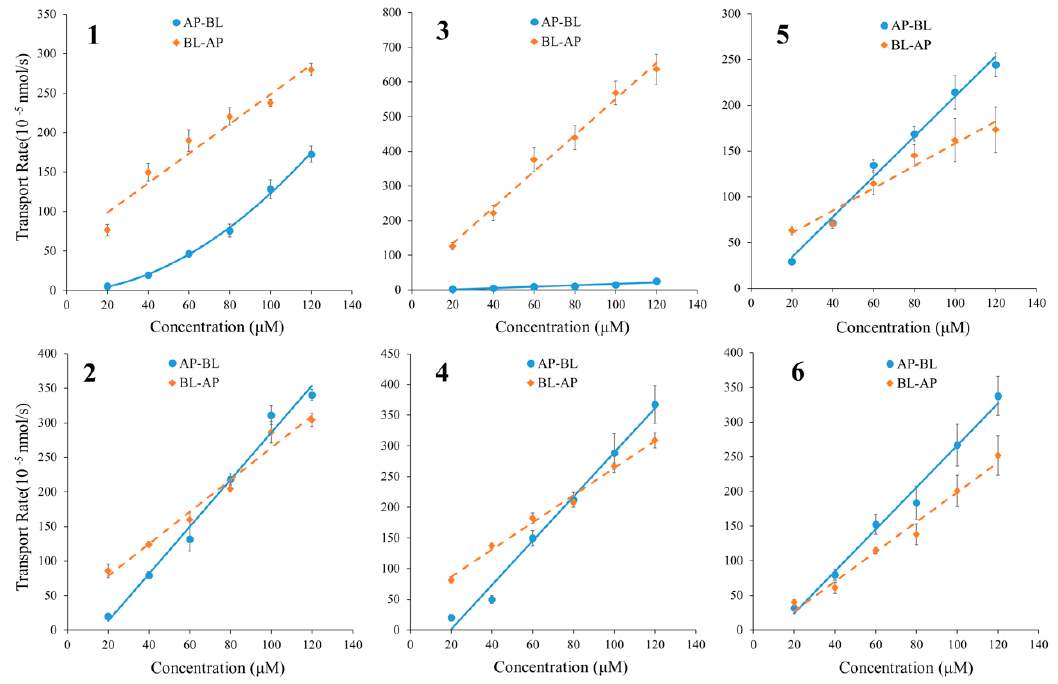
Figure 4. The bidirectional transport rates of six alkaloids in MDCK-pHaMDR cell monolayer as a function of concentration. Alkaloids 1 – 6 were at 20–120 μ M for 90 min. Data are the mean ± SD ( n = 6).